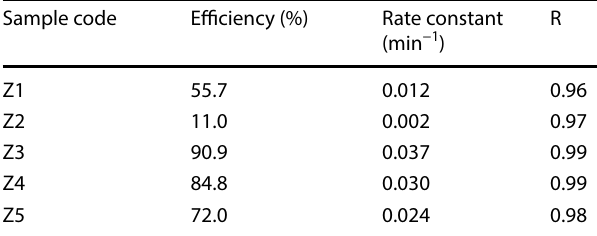
Table 2 Comparison of photodegradation efficiency of the synthe- sized photocatalysts for p -nitrophenol Sample